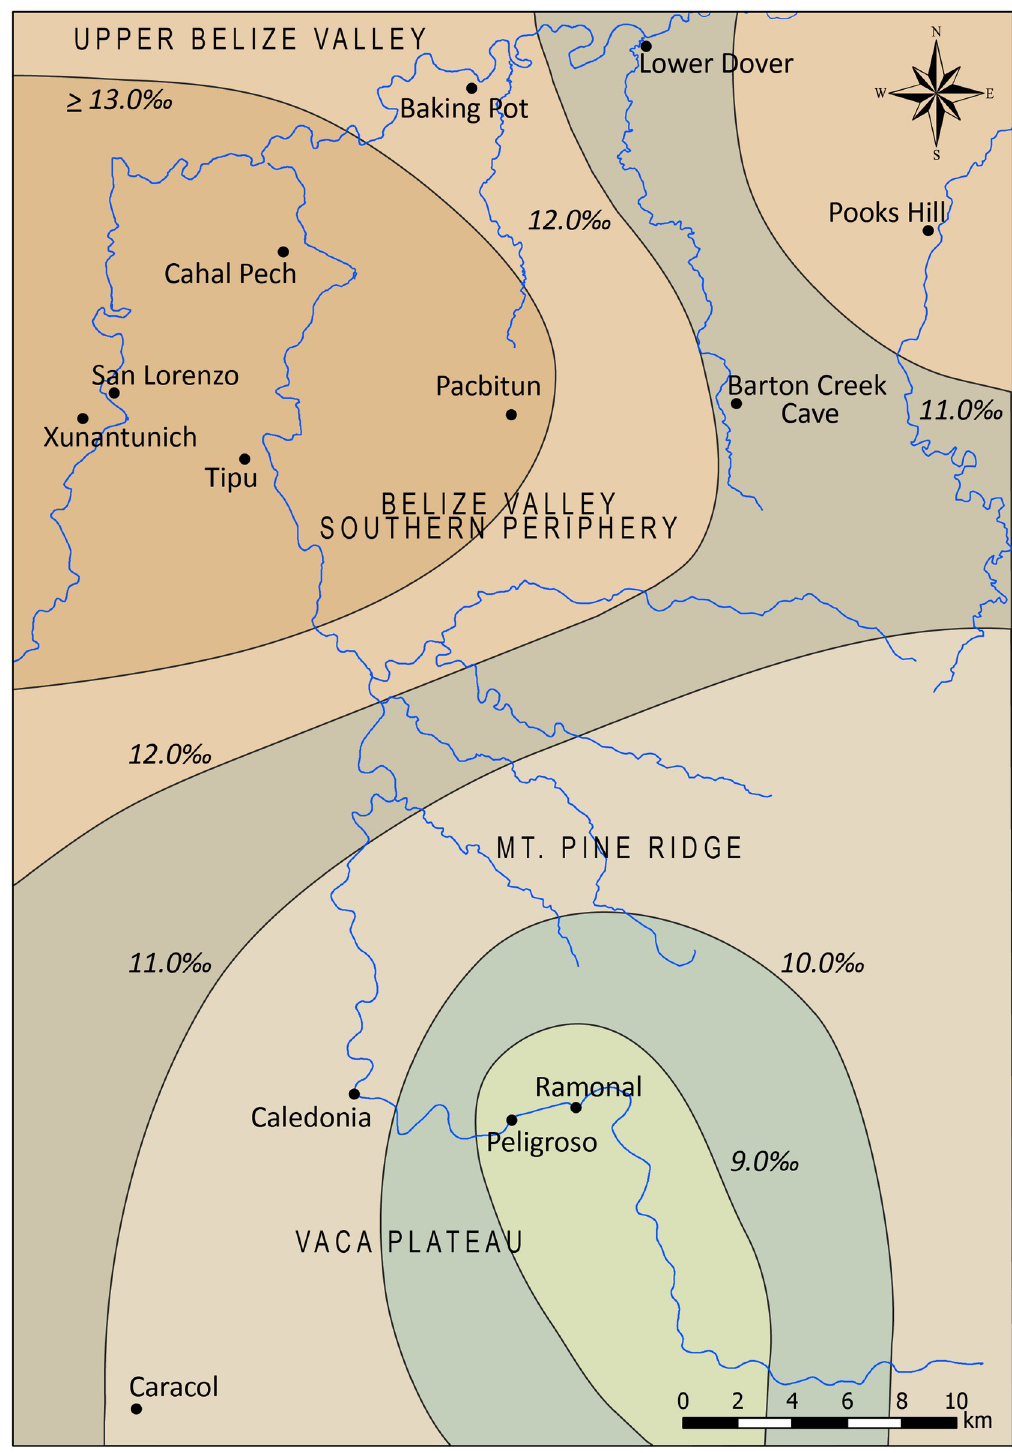
Fig 2. Modeled δ 34 S isoscape for the Eastern Maya lowlands.